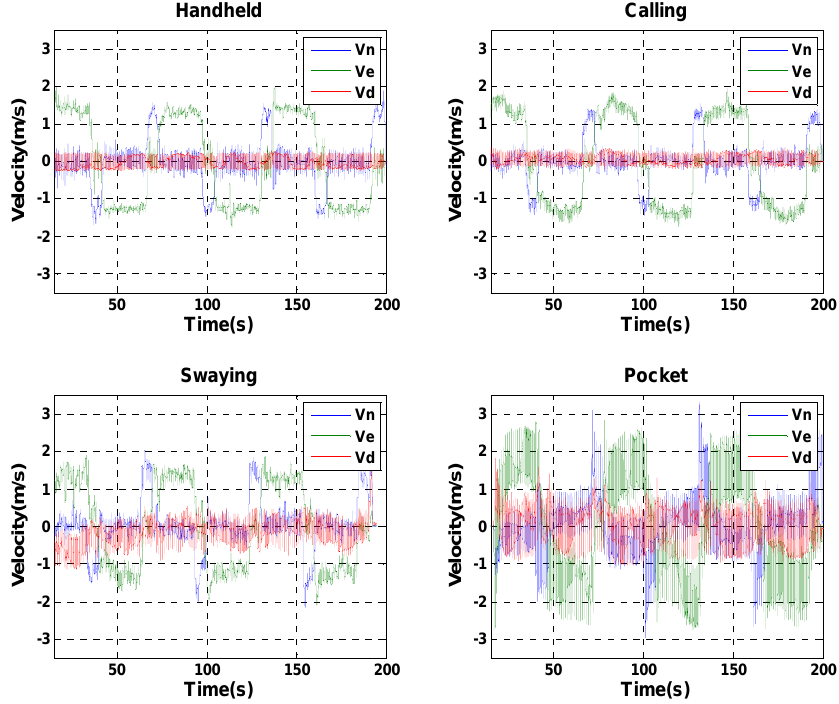
Figure 11. North, east, and down velocities of C ‐ INS solution for four different phone ‐ holding positions.